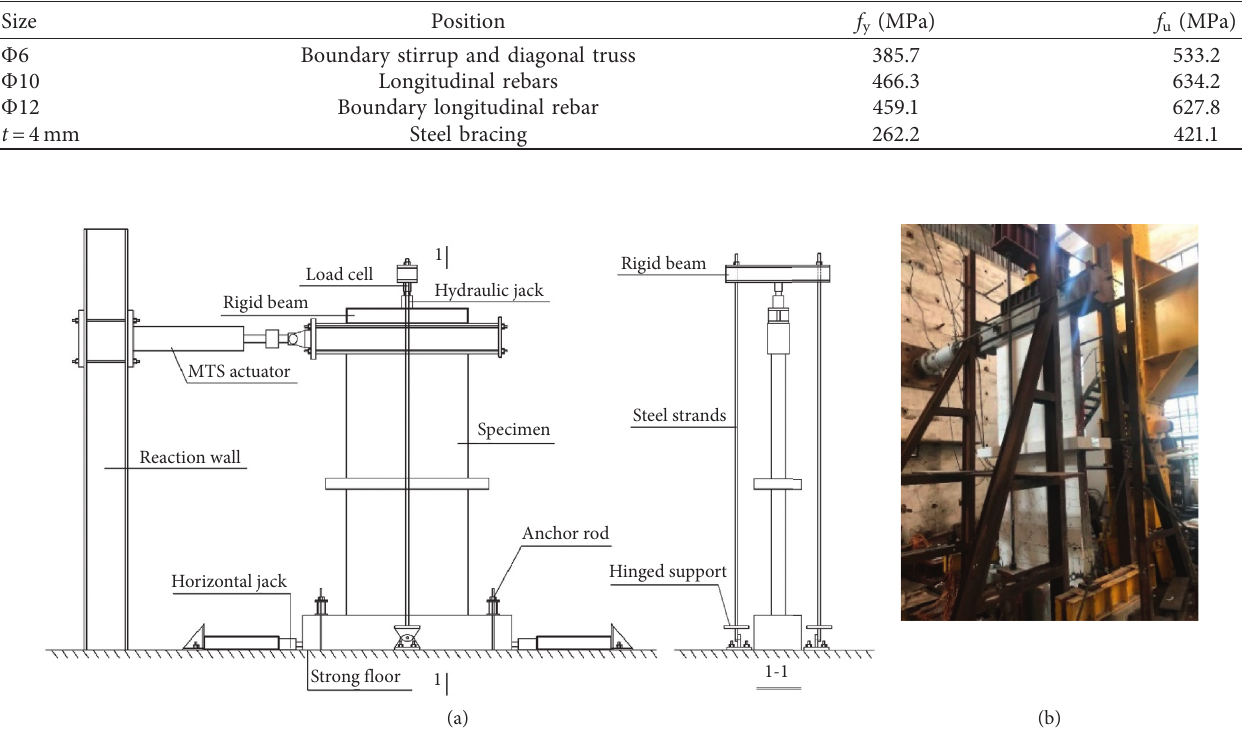
Figure 4: Test setup. (a) Schematic view. (b) Photograph.